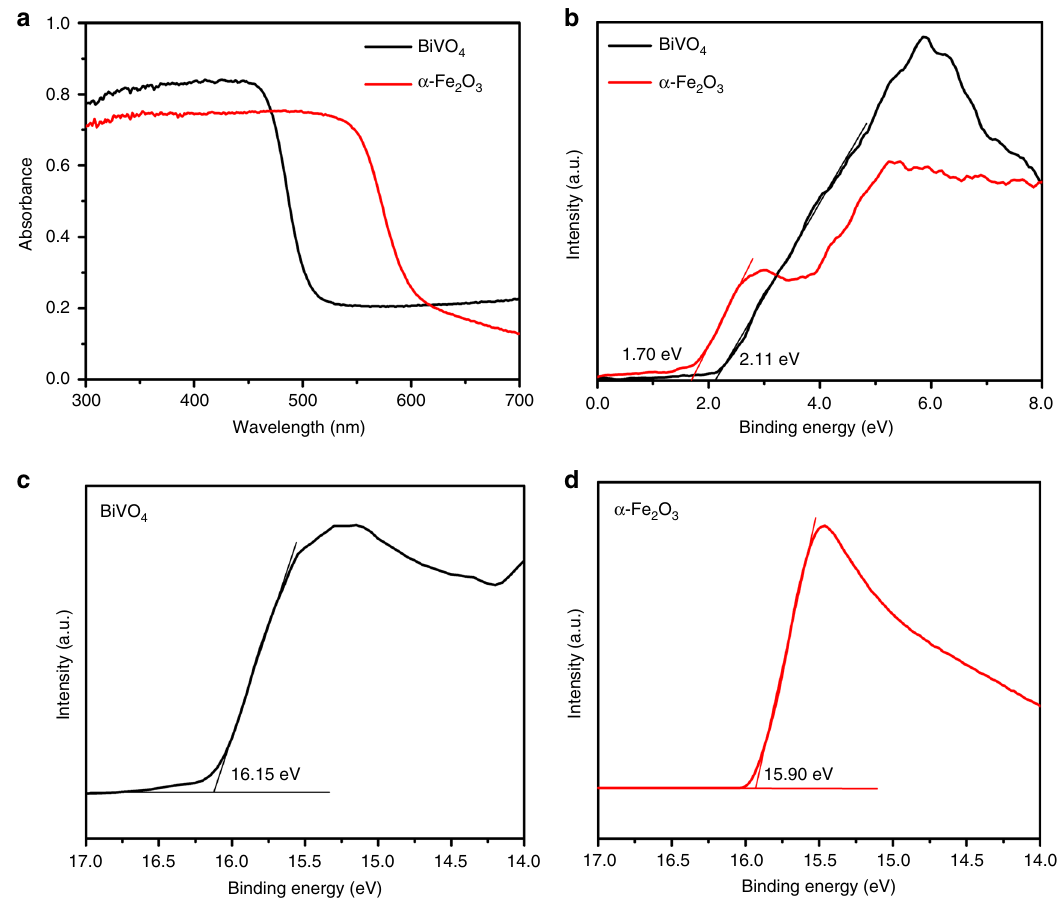
Fig. 4 Band structures of the photoelectrodes. a Ultraviolet – visible absorption spectra of the BiVO 4 and α -Fe 2 O 3 photoelectrodes. b XPS valence band spectra of the BiVO 4 and α -Fe 2 O 3 photoelectrodes. Work function data of c BiVO 4 and d α -Fe 2 O 3 are from UPS